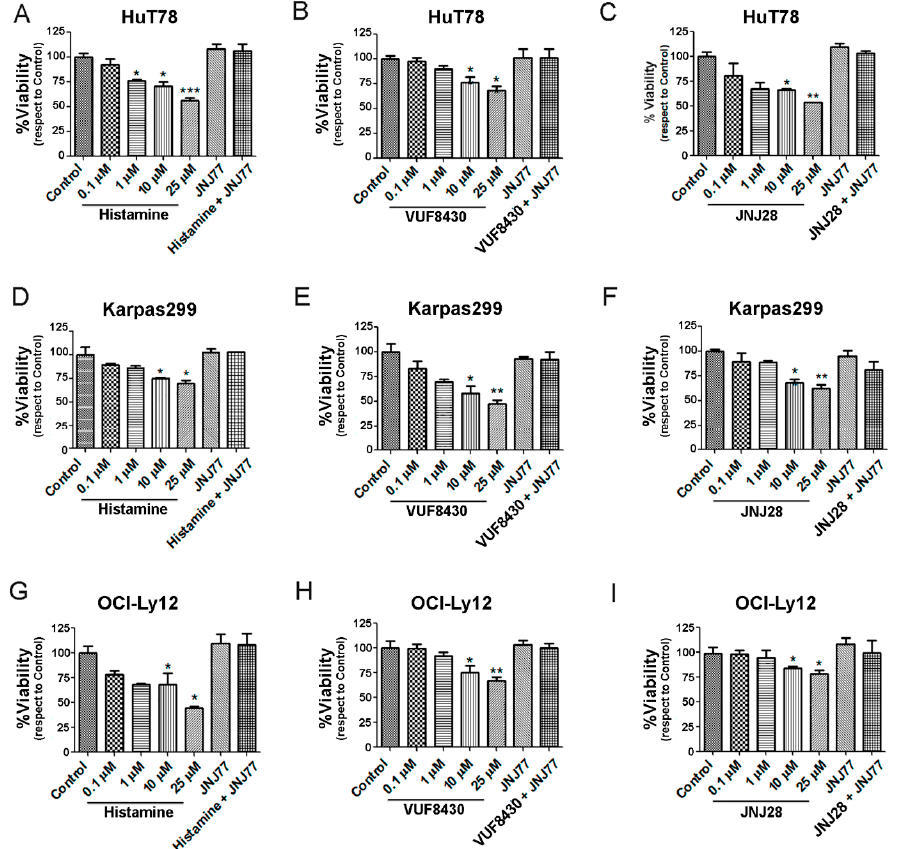
Figure 2. Effect of histamine and H4R agonists on the viability of HuT78, Karpas299, and OCI-Ly12 cells. Cells were pre-incubated for 24 h in serum-free RPMI medium and then treated as indicated: HuT78 ( A – C ), Karpas299 ( D – F ), OCI-Ly12 ( G – I ) cells were left untreated (control) or were treated with histamine, JNJ28, VUF8430 (0.1, 1, 10 and 25 µ M) or JNJ77 (10 µ M), and histamine (10 µ M), JNJ28 (10 µ M), VUF8430 (10 µ M) combined with JNJ77 (10 µ M) for 48 h in complete medium and viability was evaluated by Cell Titer Blue Assay. Measurements were performed in triplicates for each condition and cell line and data are expressed as mean ± SEM ( n = 3 independent experiments). * indicates p < 0.05, ** indicates p < 0.01, *** indicates p < 0.001 compared with